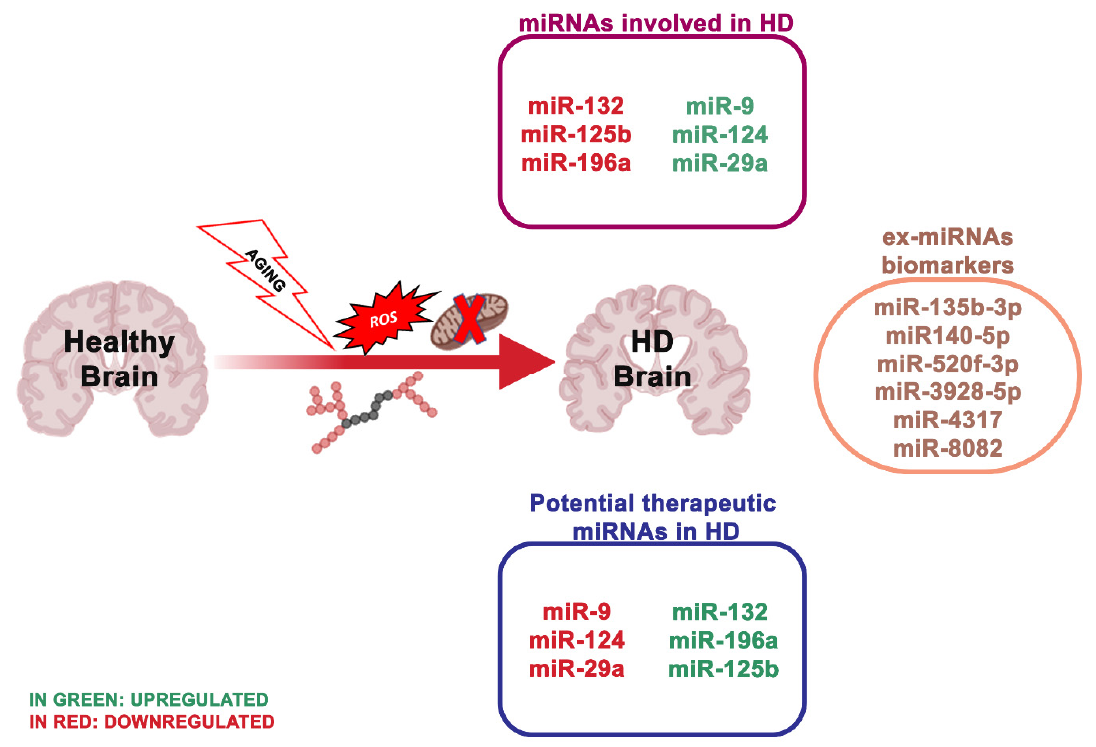
Figure 3. The most essential miRNAs involved in Huntington’s disease.